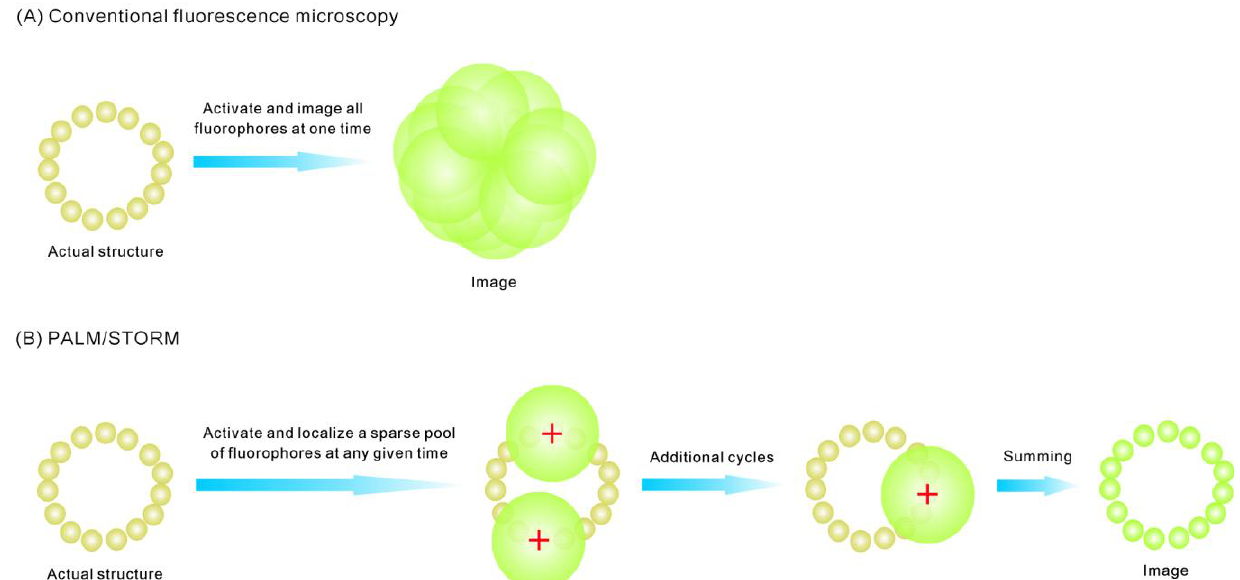
Figure 4. Principles of PALM/STORM. ( A ) In conventional fluorescence microscopy, all fluorophores are excited at once, thus the diffraction-limited areas from closely positioned fluorophores overlap; ( B ) PALM/STORM excites only a small subset of fluorophores at any given time, so the diffraction-limited areas of each fluorophore no longer overlap. The precise location of each fluorophore can be determined by finding its intensity centroid from the detected fluorescence image. By repeating the cycle, the many measured locations of distinct fluorophores in the entire cell are superimposed to generate a final super-resolution